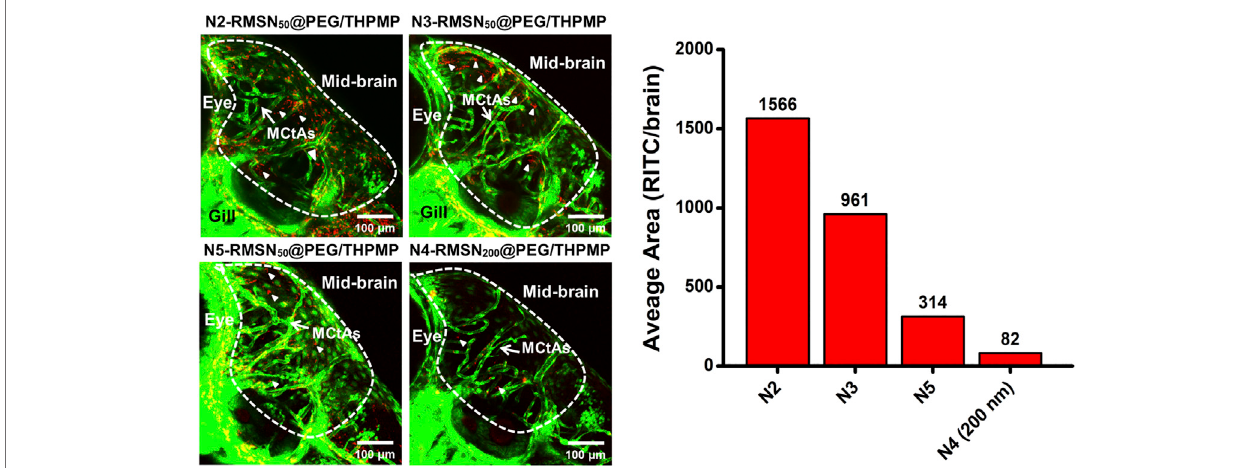
FIGURE 4 | Confocal microscopic images of four different negatively charged RITC-conjugated mesoporous silica nanoparticles (RMSNs) with different sizes (50 and 200 nm) in zebra fi sh larval midbrain. White arrows indicate mesencephalic central arteries (MCtAs); arrowheads indicated red fl uorescence (RITC) of nanoparticles outside the brain ’ s blood vessels (GFP,